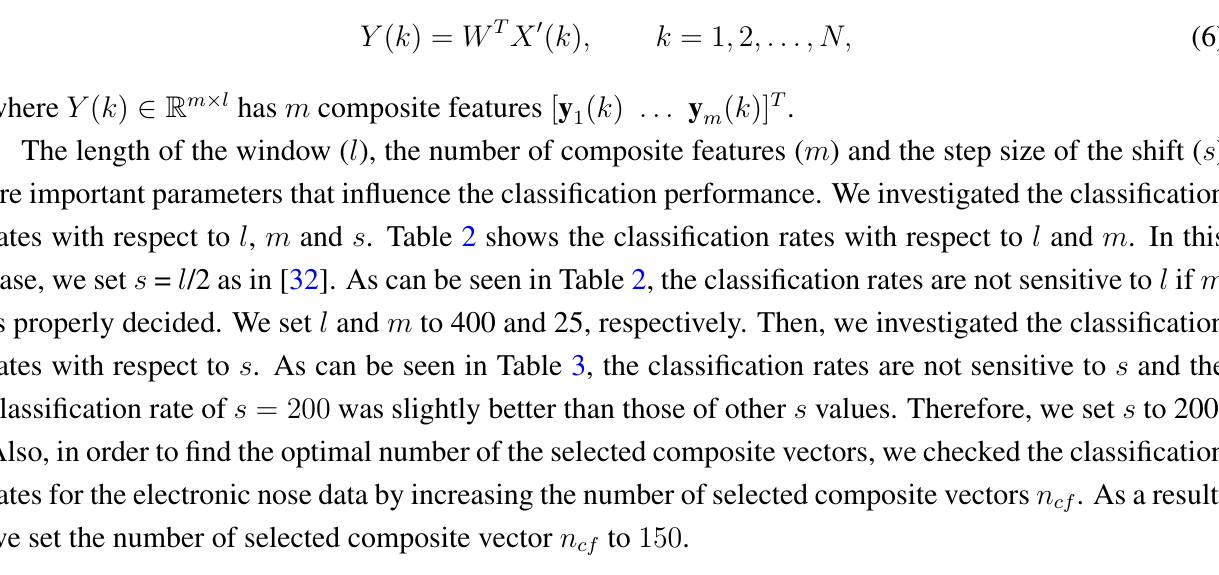
Table 2. Classification rates with respect to l and m .